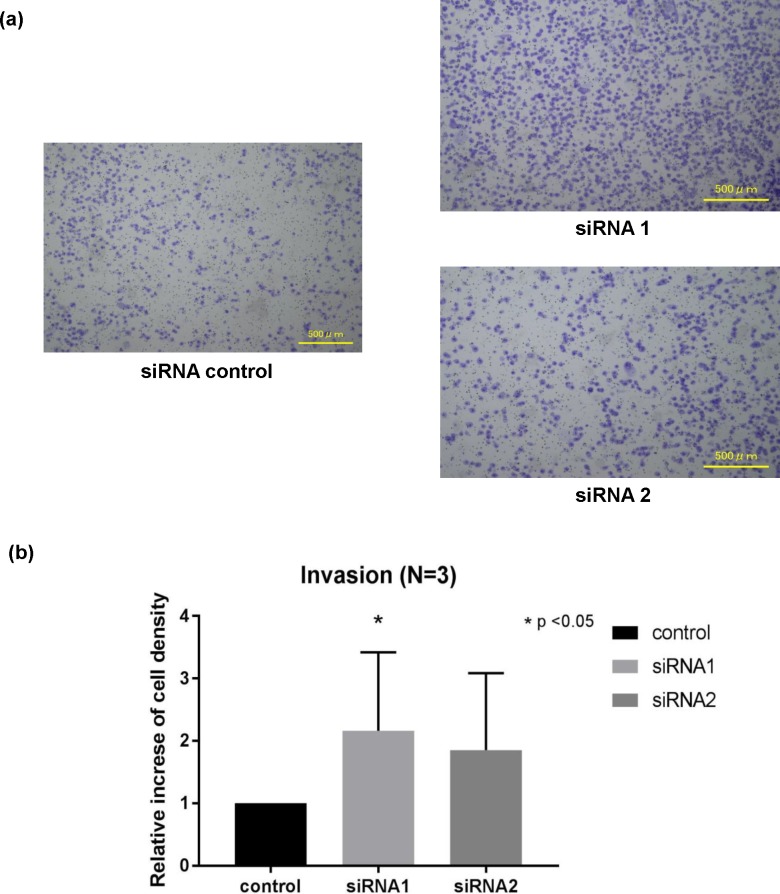
Invasion assay in BAP1 knockdown GBC cell line.(a) The GBC cell line G-415 was transfected with siRNA against BAP1 and was seeded on a Matrigel invasion chamber and the infiltrated cells on the lower surface of the chamber were stained. (b) Compared to the control group, the number of infiltrated cells tended to increase in both siRNA1 and siRNA2, and the number of infiltrated cells was significantly higher in the siRNA1.